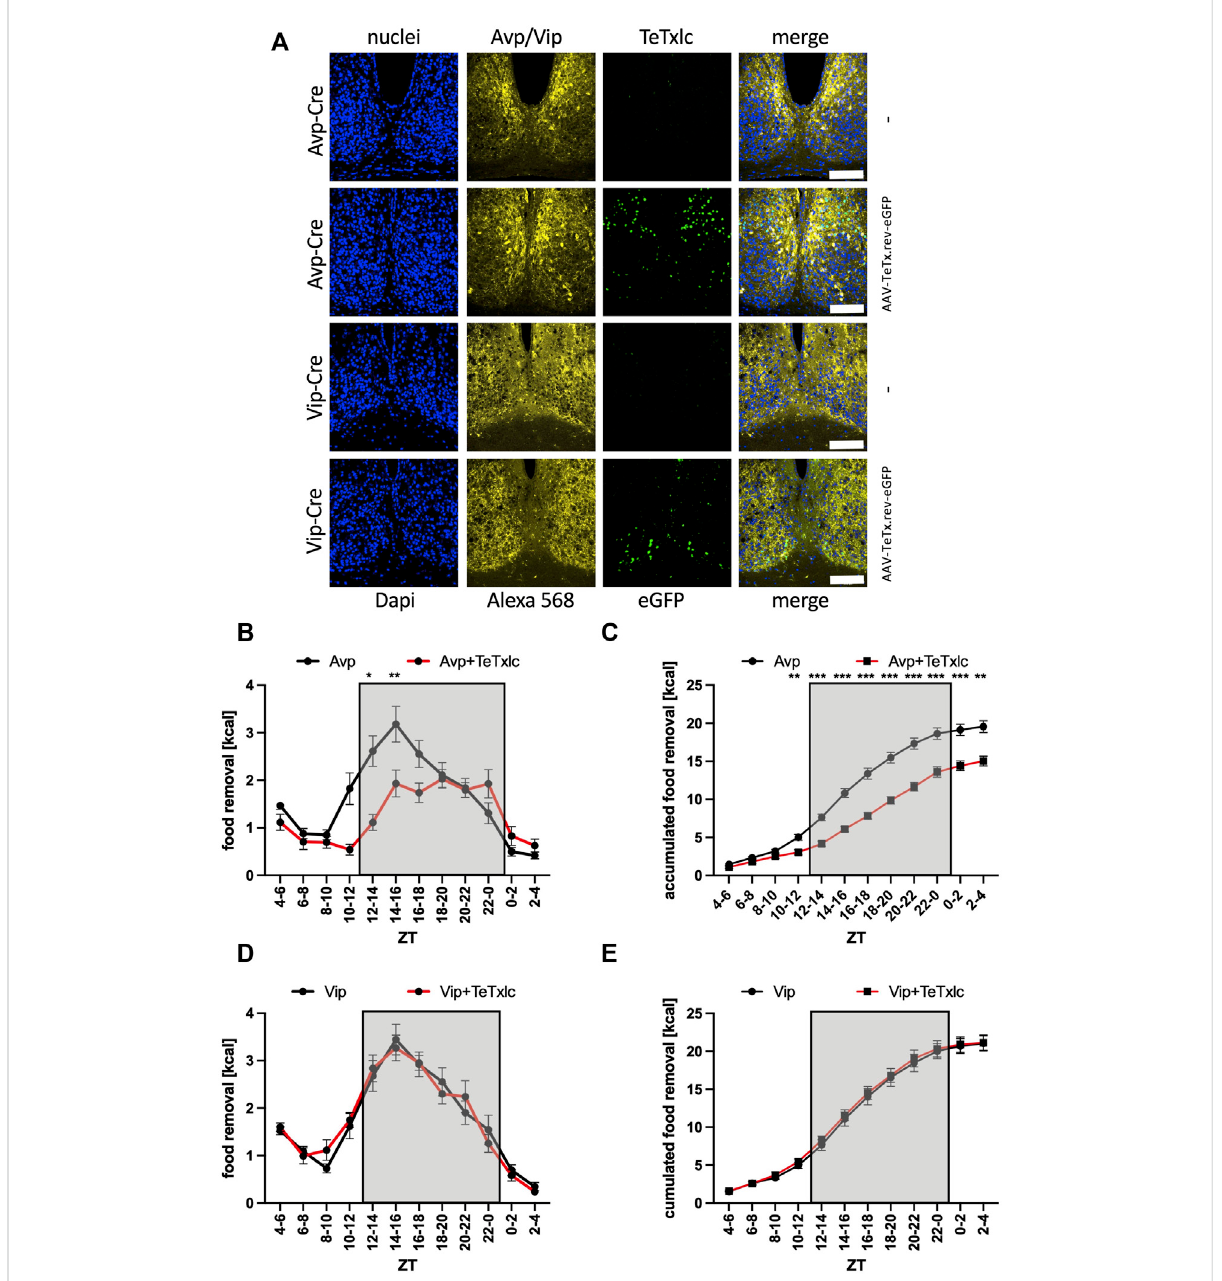
Increase of food removal during the early activity phase is mediated by the Avp subregion. (A) Immuno fl uorescence staining of the localization ofAvporVip withintheSCN(Alexa568,yellow) anddetection ofeGFP(green)within theAvp orVipsubregions.×40 objective(numericalaperture = 1.3, oil), a white bar measures 100 μ m. (B) Food removal in each 2 h bin starting from ZT4-6 for Avp-Cre mice (black) or Avp-Cre mice injected with reversedTeTxlc (red)into theSCN(2-wayrepeated measureANOVA, N=12, p < 0.001,F=20.42,DFn=1,DFd=22). (C) Accumulation offood removaloverthecourseoftheexperiment3B(2-wayrepeatedmeasureANOVA,N=12, p < 0.001,F=38.85,DFn=1,DFd=22). (D) Foodremovalin each2 hbinstarting fromZT4-6for Vip-Cremice(black)orVip-Cremiceinjected withreversedTeTxlc(red)intotheSCN(2-way